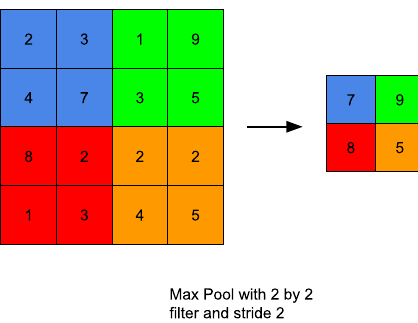
Figure 3. Maximum pooling operation.